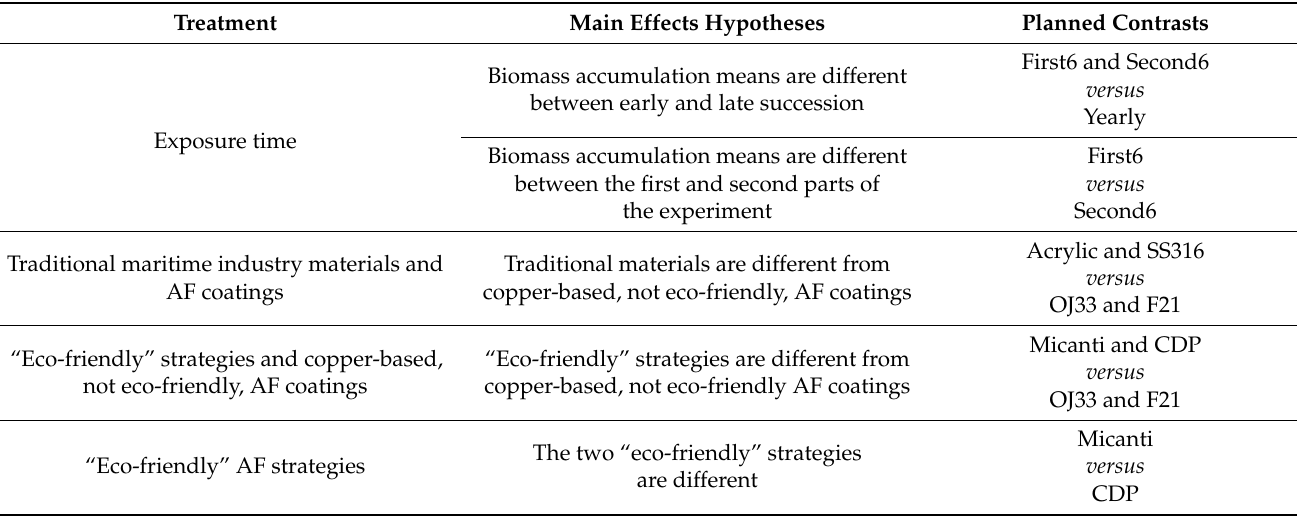
Table 1. Specific hypotheses and planned orthogonal contrasts for main effects treatments at each